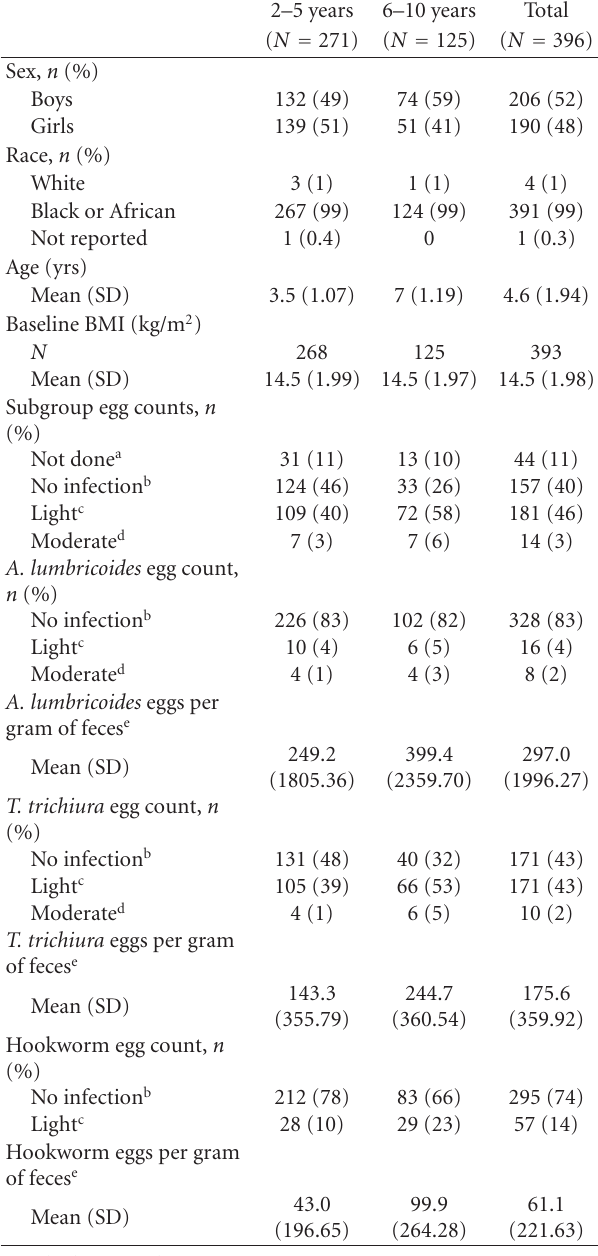
Table 1: Patient demographics and baseline